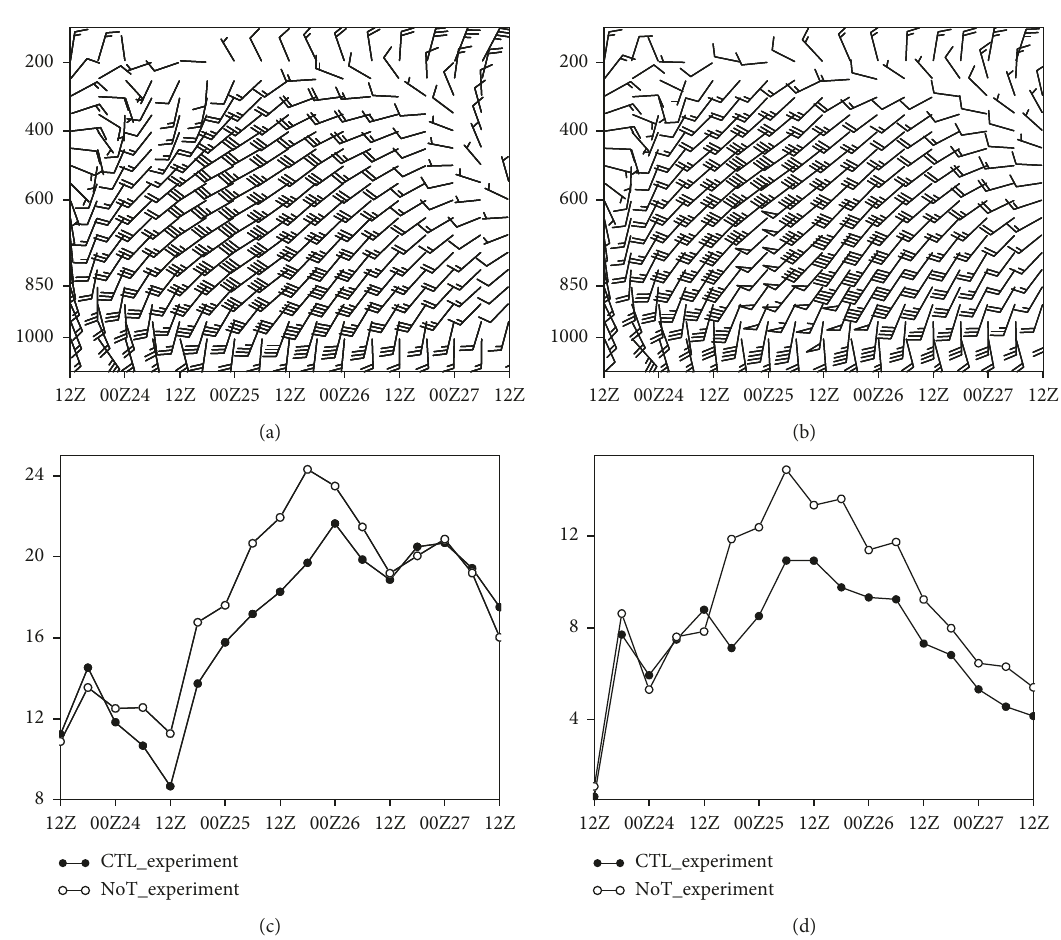
Figure 12: The simulated pressure-time cross sections of the area-averaged (1000km × 1000km) horizontal winds over Typhoon Bolaven ((a) CTL experiment and (b) NoTexperiment) and time series of the area-averaged (1000km × 1000km) magnitude of the simulated deep- layer shear vector (c) and low-layer shear vector (d) in the CTL experiment (black circle line) and NoT experiment (white circle line), respectively (unit: m s − 1